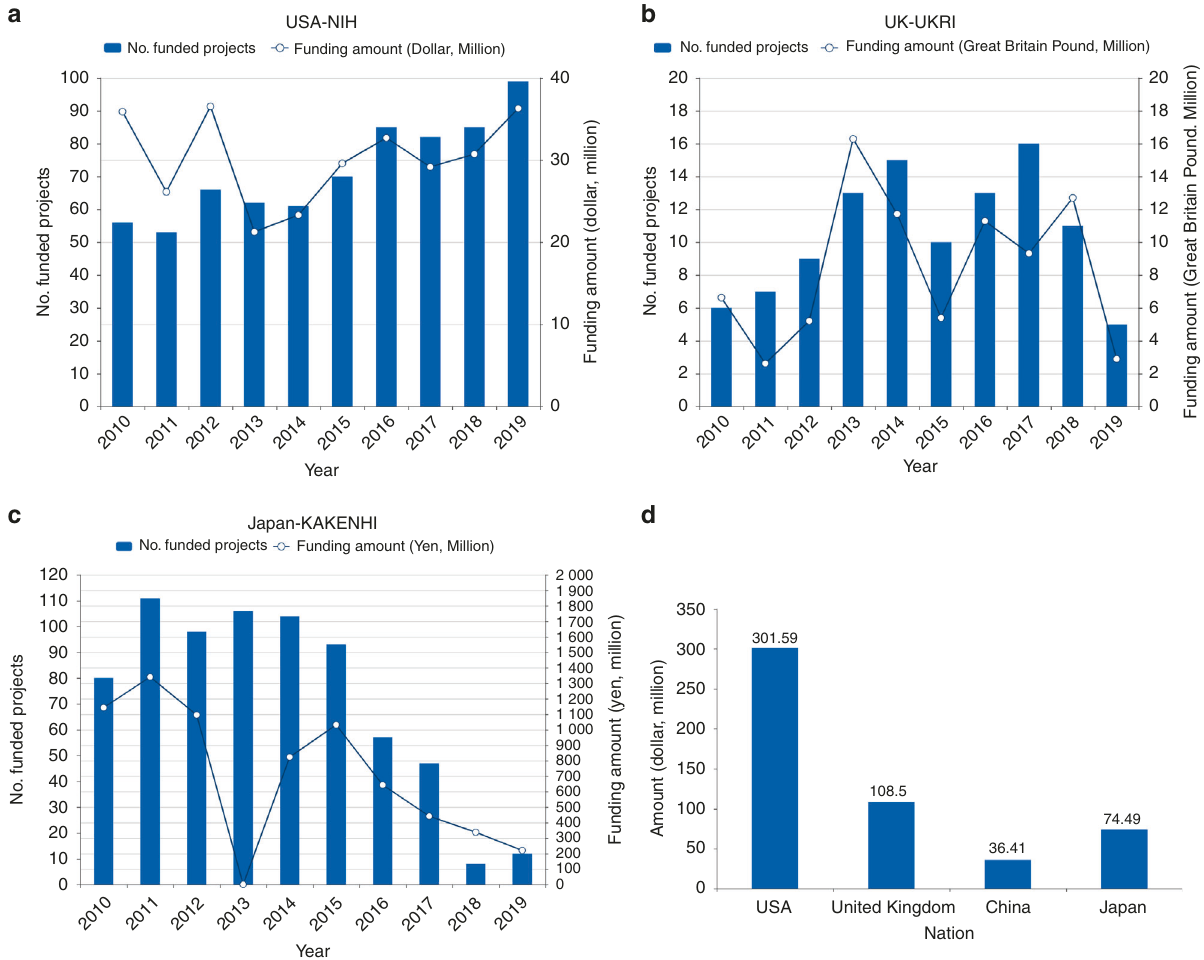
Fig. 2 Comparison of national basic research grant support in the fi eld of OA among the NIH, UKRI and KAKENHI (2010 – 2019). a Changes in the number of funded projects and funding amounts of the NIH in the USA. b Changes in the number of funded projects and funding amounts of UKRI in the United Kingdom. c Changes in the number of funded projects and funding amounts of KAKENHI in Japan. d Comparison of the amounts of grants allotted for OA research in the USA, United Kingdom, China and